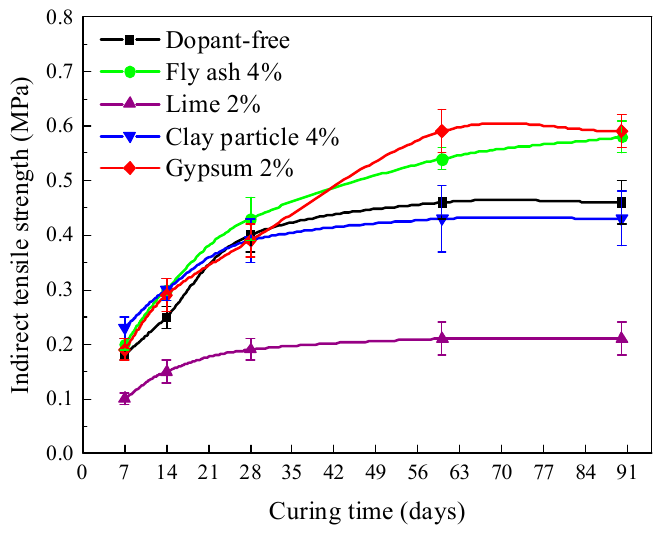
Figure 7. Curve of indirect tensile strength with optimal content of the additives.